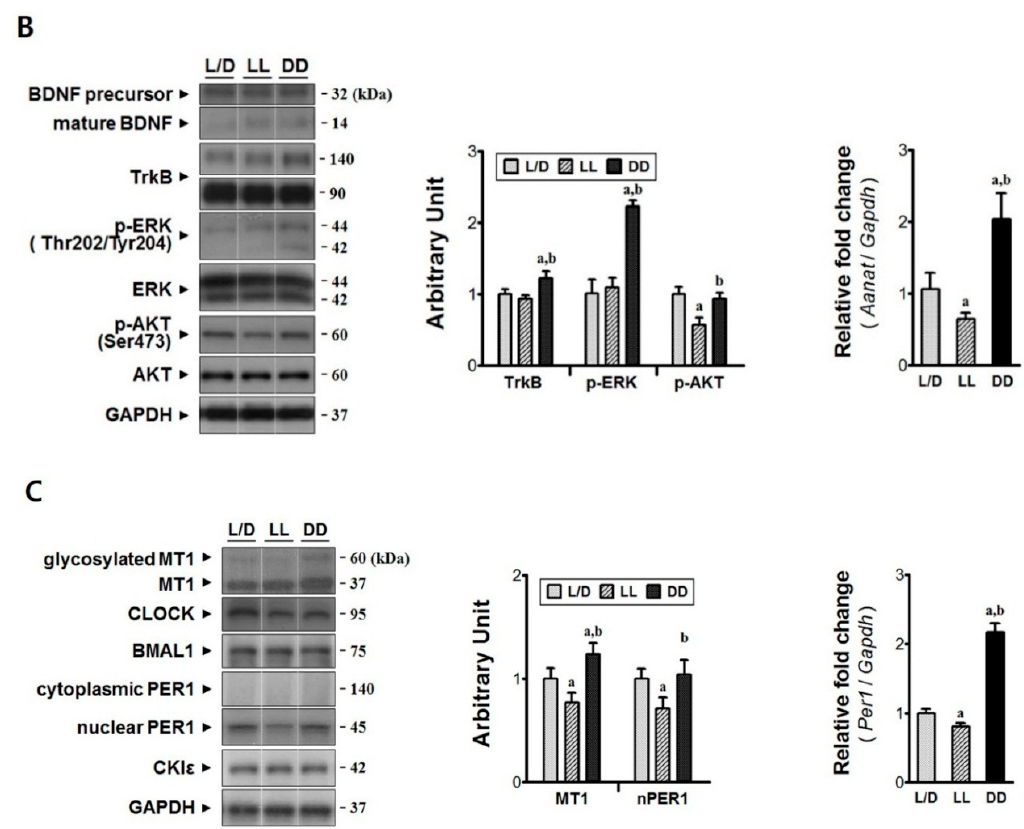
Figure 5. Constant dark condition preserves excitatory circuits at the acute phase in the lumbar enlargement. The spinal segments caudal to the injury epicenter (L1-2) were analyzed at POD 3. ( A ) LL condition led to the reduction of the neuroglial markers (GFAP, NeuN) as well as extensive tissue damage in the secondary lesion. Both PSD-95 and Olig2 proteins were augmented when DD condition was applied. Neuronal degeneration found in histological examination could be an evidence supporting these results. VC, ventral commissure; Magnification = × 200; Scale bar = 40 µ m; ( B ) Increased Aanat expression under DD condition activated TrkB-ERK signal transduction, but its repression under LL condition inhibited AKT-dependent intracellular signal; ( C ) LL condition decreased Per1 expression, nuclear distribution of PER1 protein, and glycosylated MT1 level, which was preserved under DD condition. L/D, 12/12-h light/dark; LL, 24-h constant light; DD, 24-h constant dark. a p < 0.05 vs. L/D; b p < 0.05 vs. LL.